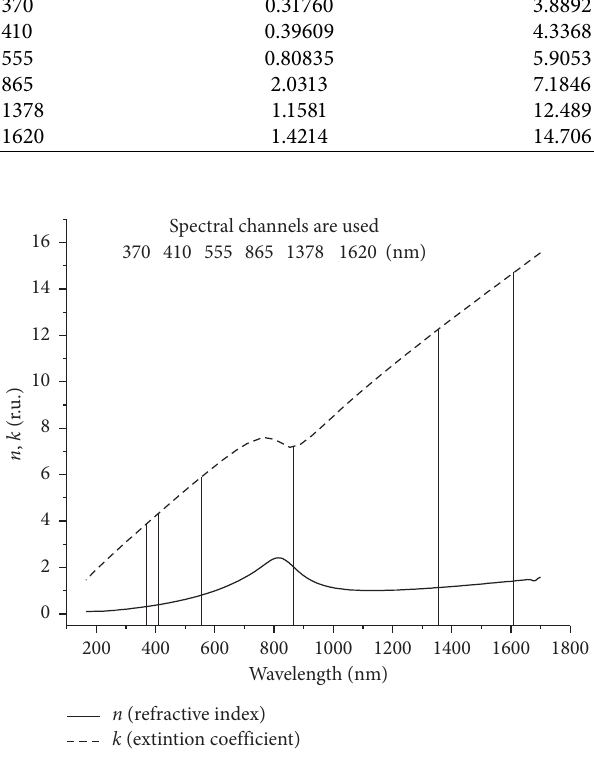
Figure 6: Dispersion of real and imaginary parts of complex re- fractive index of a thick layer of aluminum